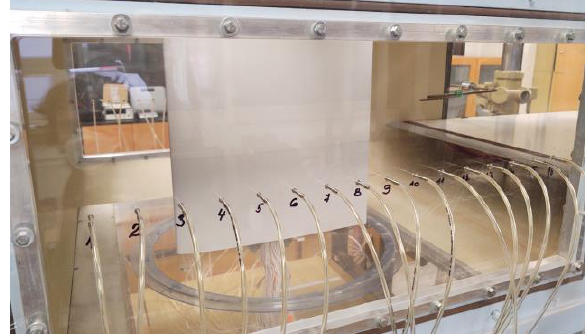
Fig. 3. Side view on the model (placed vertically) inside the test-section of the